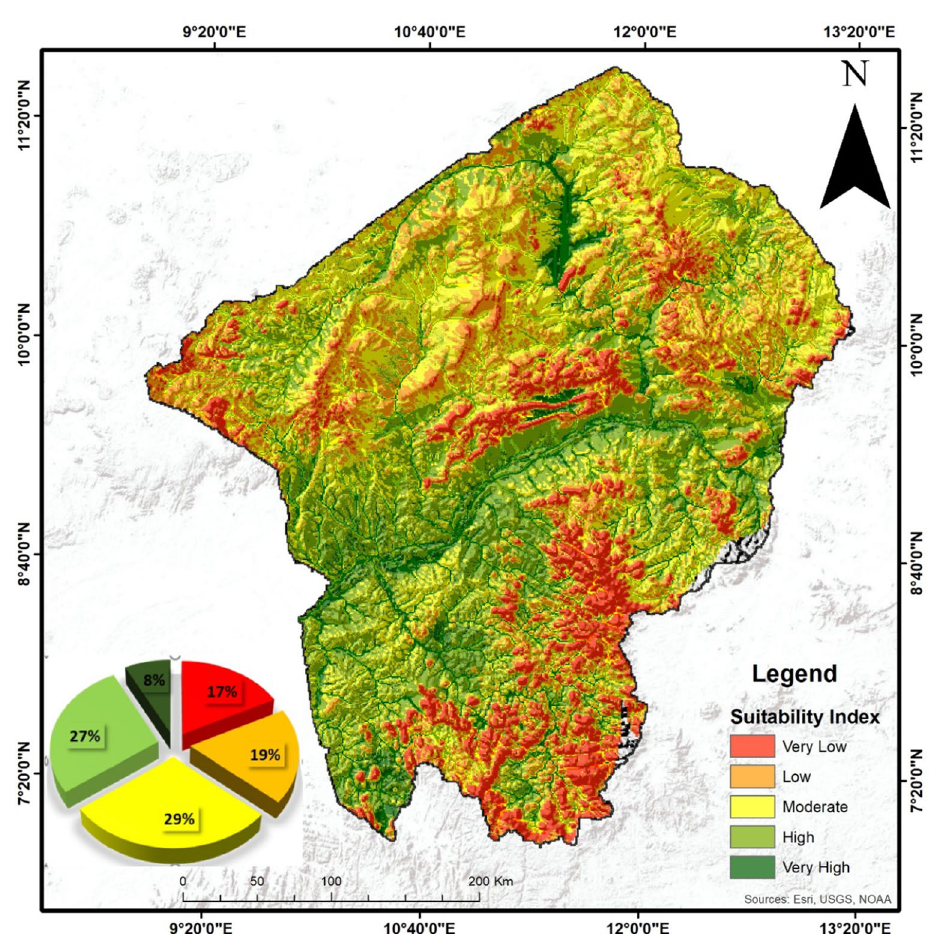
Fig. 5 Suitability map for SHP